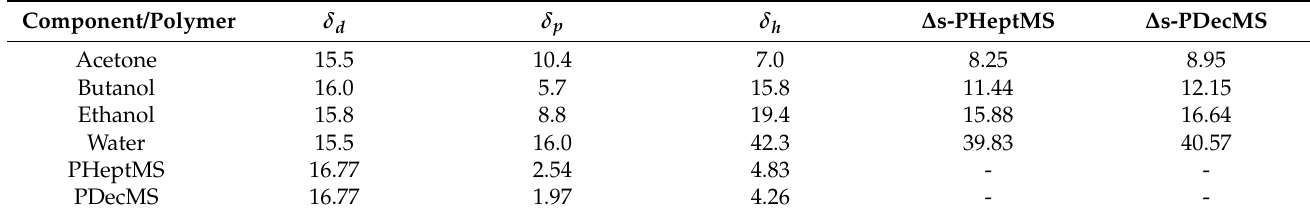
Table 2. Hansen solubility parameters.